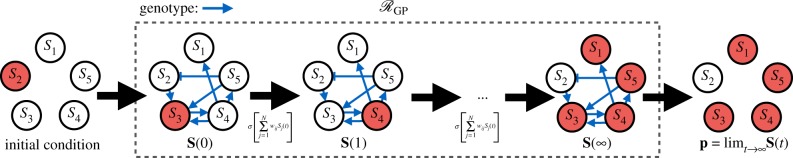
Schematic of the gene regulatory model for a GP-mapping. The genotype (blue arrows) defines the regulatory actions of genes on one another. The phenotype, p, is determined by the stable state for the network, under the update rule specified in equation (3.10). The initial condition of the network can be taken to be genetic, environmental, or arbitrary, depending on the specifics of each study. (Online version in colour.)